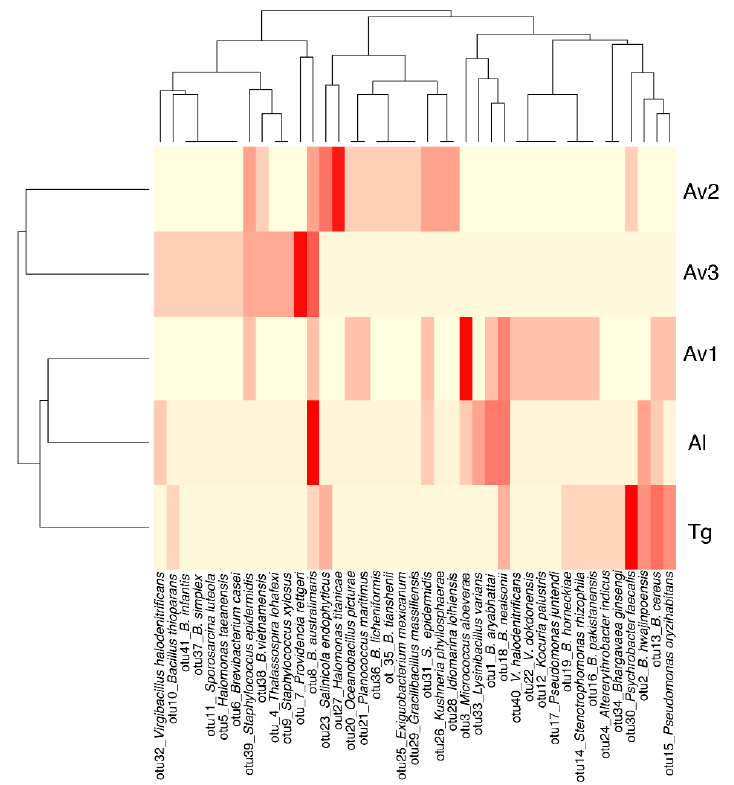
Figure 2. Heatmap showing relative abundance of OTUs in the subsets corresponding to each sampling. Dendrograms show hierarchical clustering between OTUs and sampling sites.